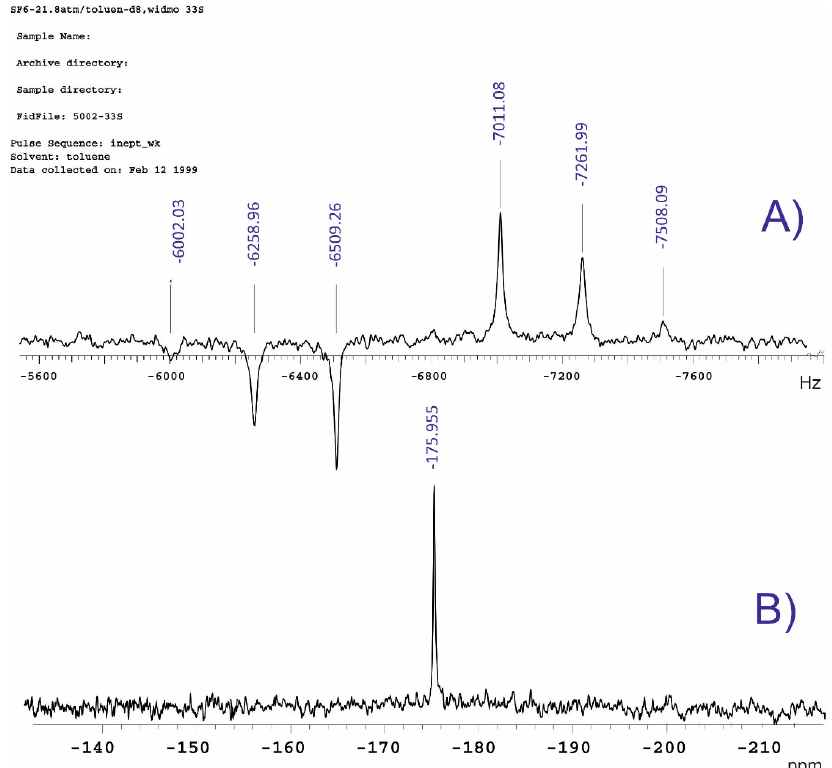
Figure 2. The 33 S NMR spectra of gaseous SF 6 at 21.8 atm: ( A ) coupled to six fluorine nuclei, and ( B ) decoupled fluorine.